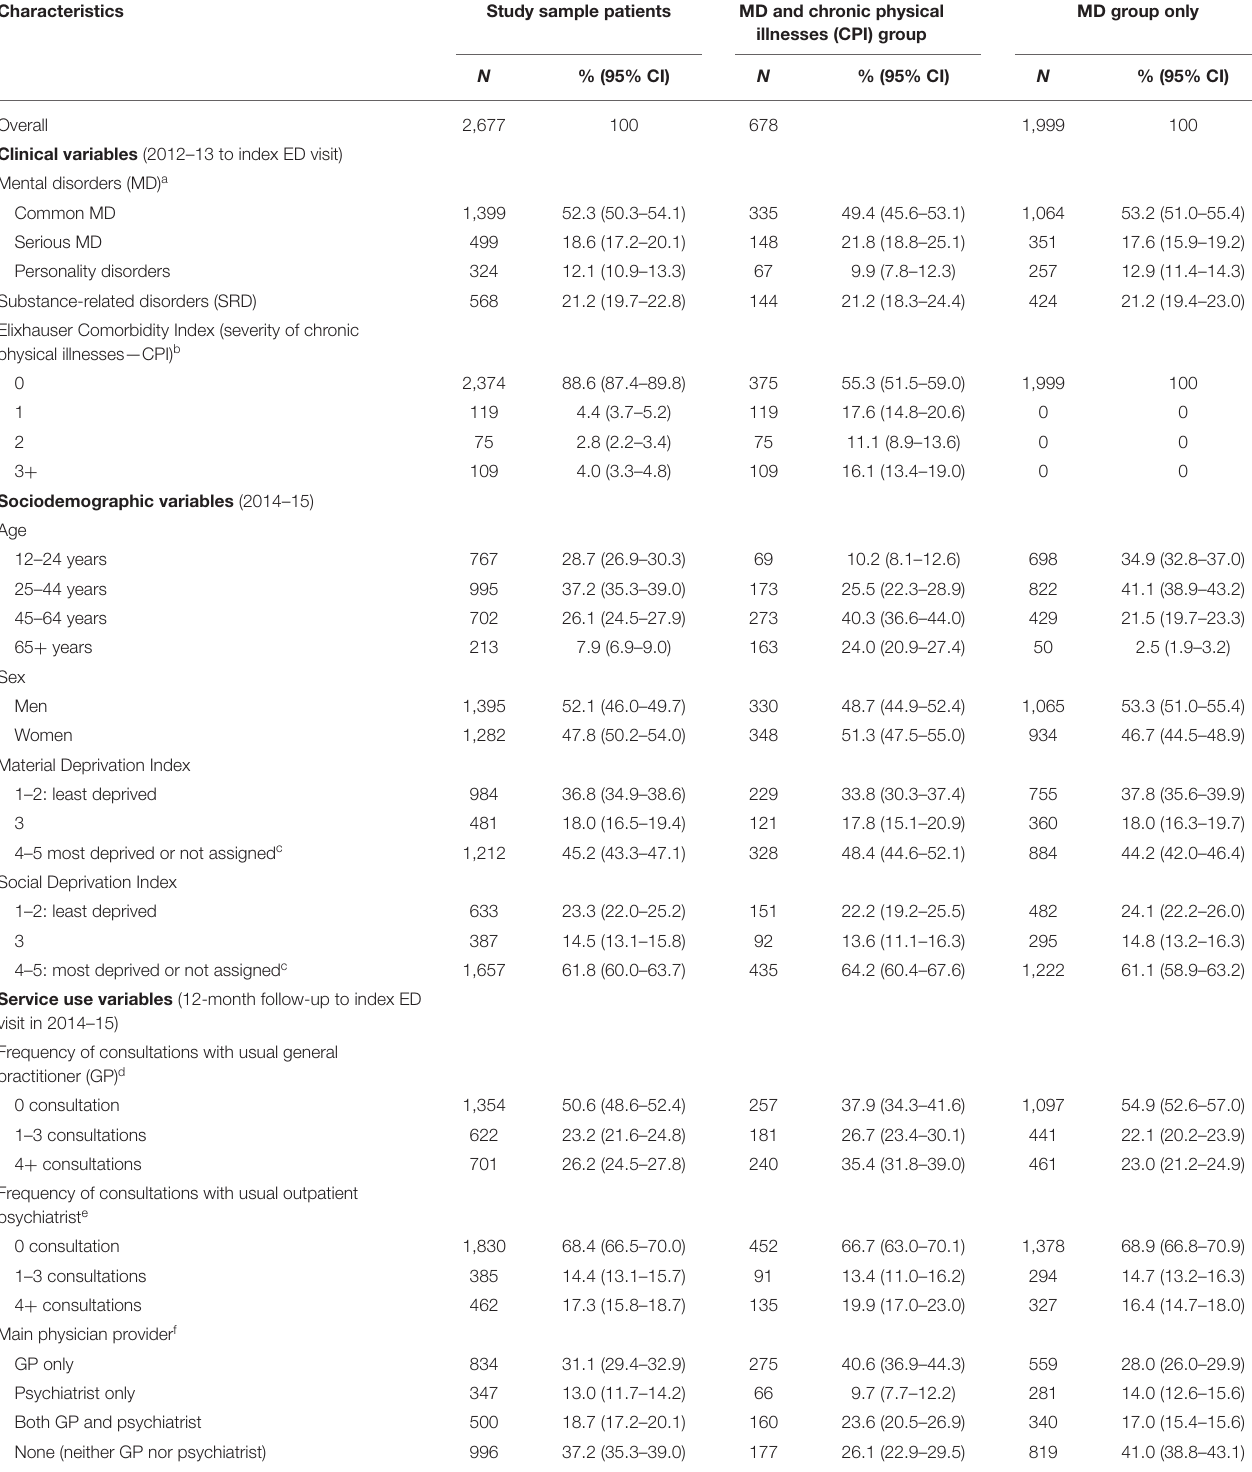
TABLE 2 | Characteristics of patients at onset of a mental disorder (MD) including substance-related disorders (SRD) who used emergency departments (ED) in the index year 2014–15.